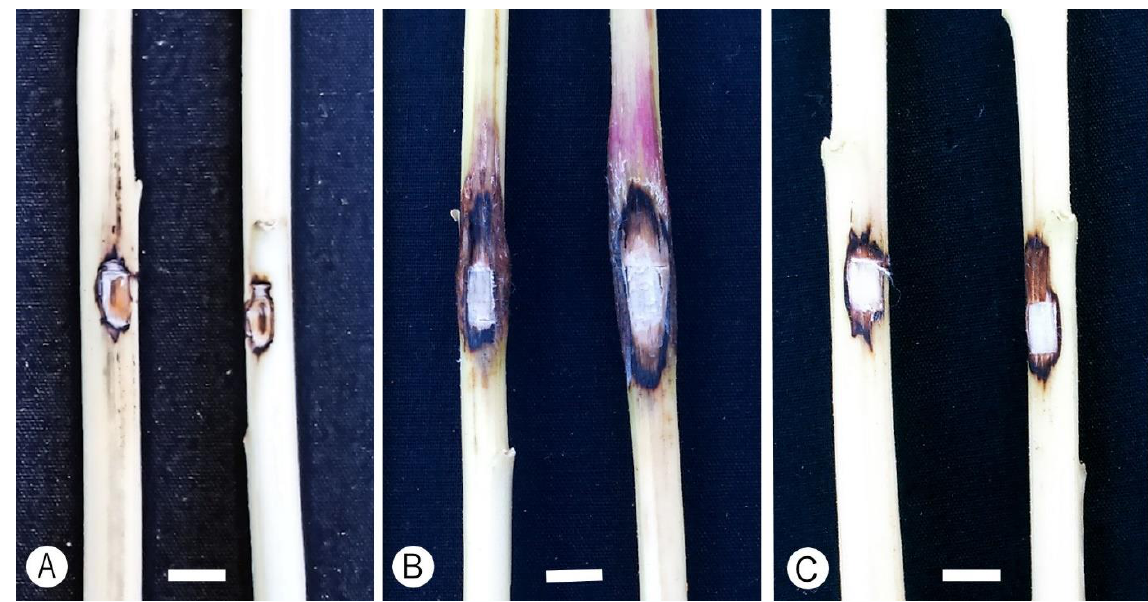
Figure 5. Lesions produced on Amaranthus cruentus in pathogenicity trials. ( A ) Control. ( B ) Inoculations with Fusarium casha (PPRI 21883). ( C ) Inoculation with F. curculicola (PPRI 20458). Bars: 5 mm. Table 4. Results of pathogenicity tests with Fusarium casha and F. curculicola on Amaranthus cruentus . Mean Lesion Length (mm)